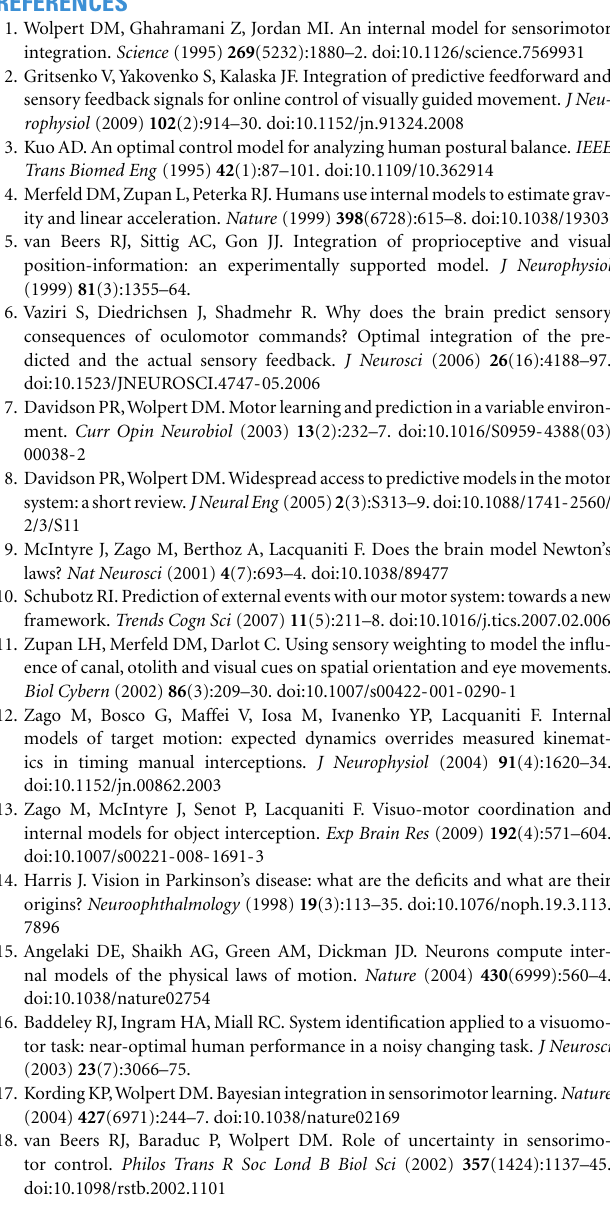
Figure S1 | Regression analysis – log(decay rate) .The regression was the same as for Figure 4 , only the dependent variable used in the regression was log(decay rate). Figure S2 | Regression weights of the vector decomposition in Figure 2, comparing the situations with and without